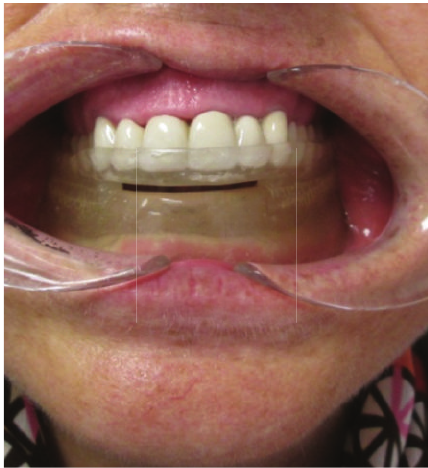
Figure 2: Device in patient’s mouth.